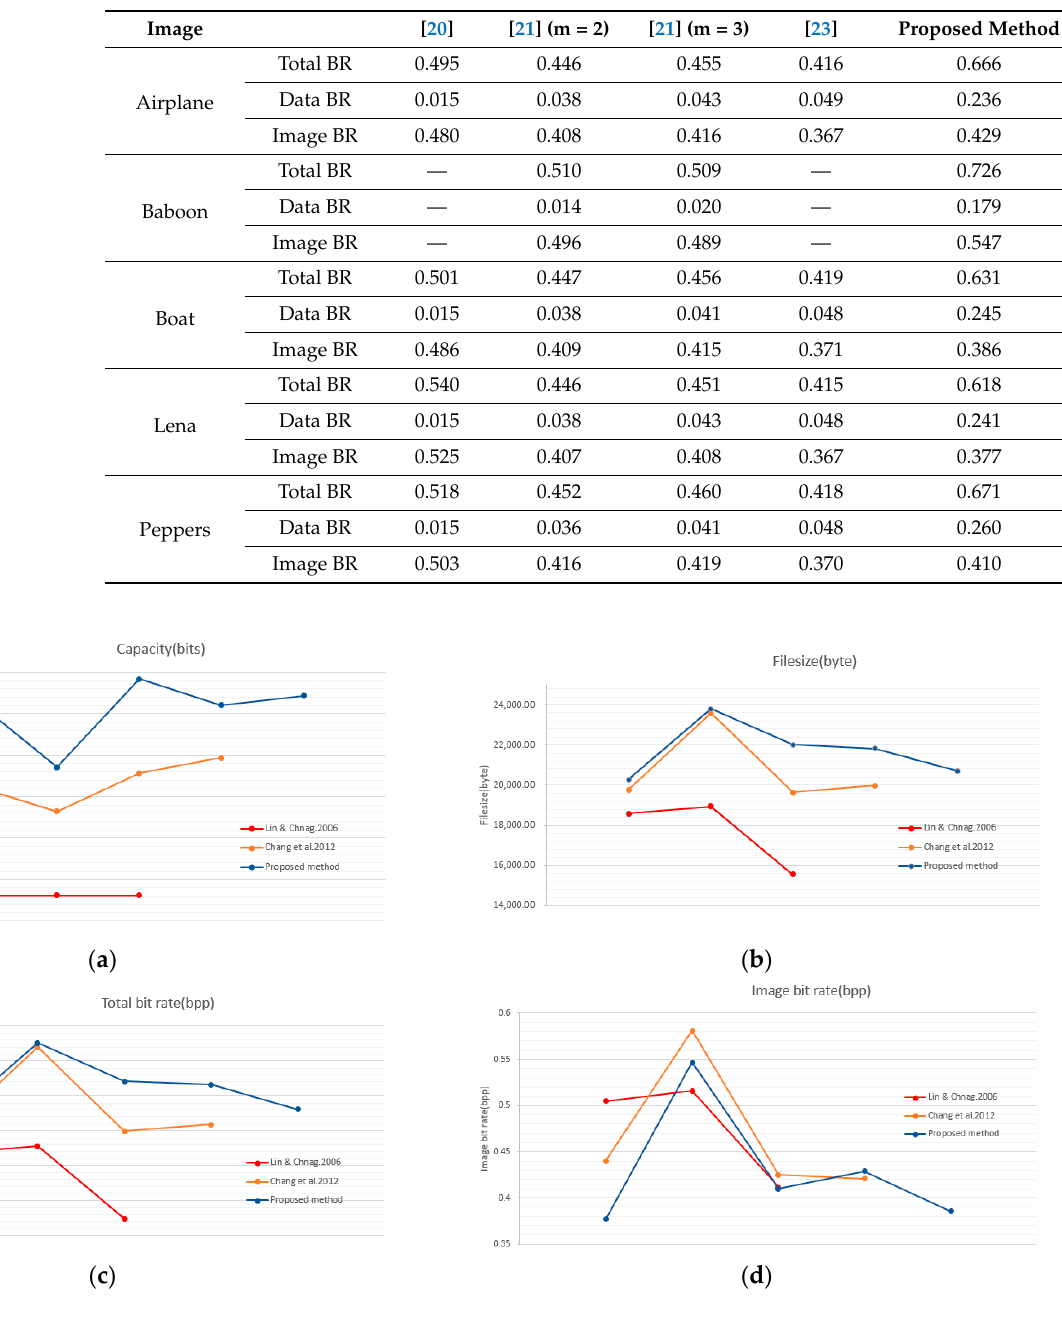
Table 8. Total bitrate, data bitrate, and image bitrate of SOC-based schemes.